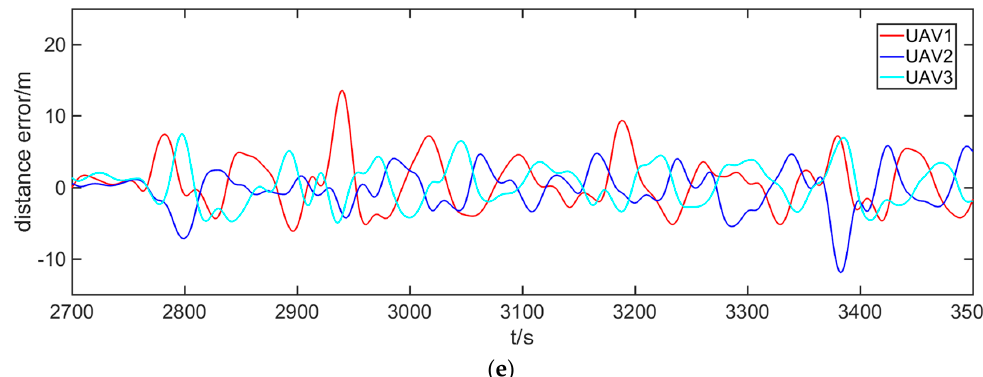
Figure 21. The standoff tracking distance error. ( a ) Distance error in the “gather” stage; ( b ) Distance error in the “phase adjusting” stage; ( c ) Distance error in the “high-speed” stage; ( d ) Distance error in the “low-speed” stage; ( e ) Distance error in the “accelerating” stage.